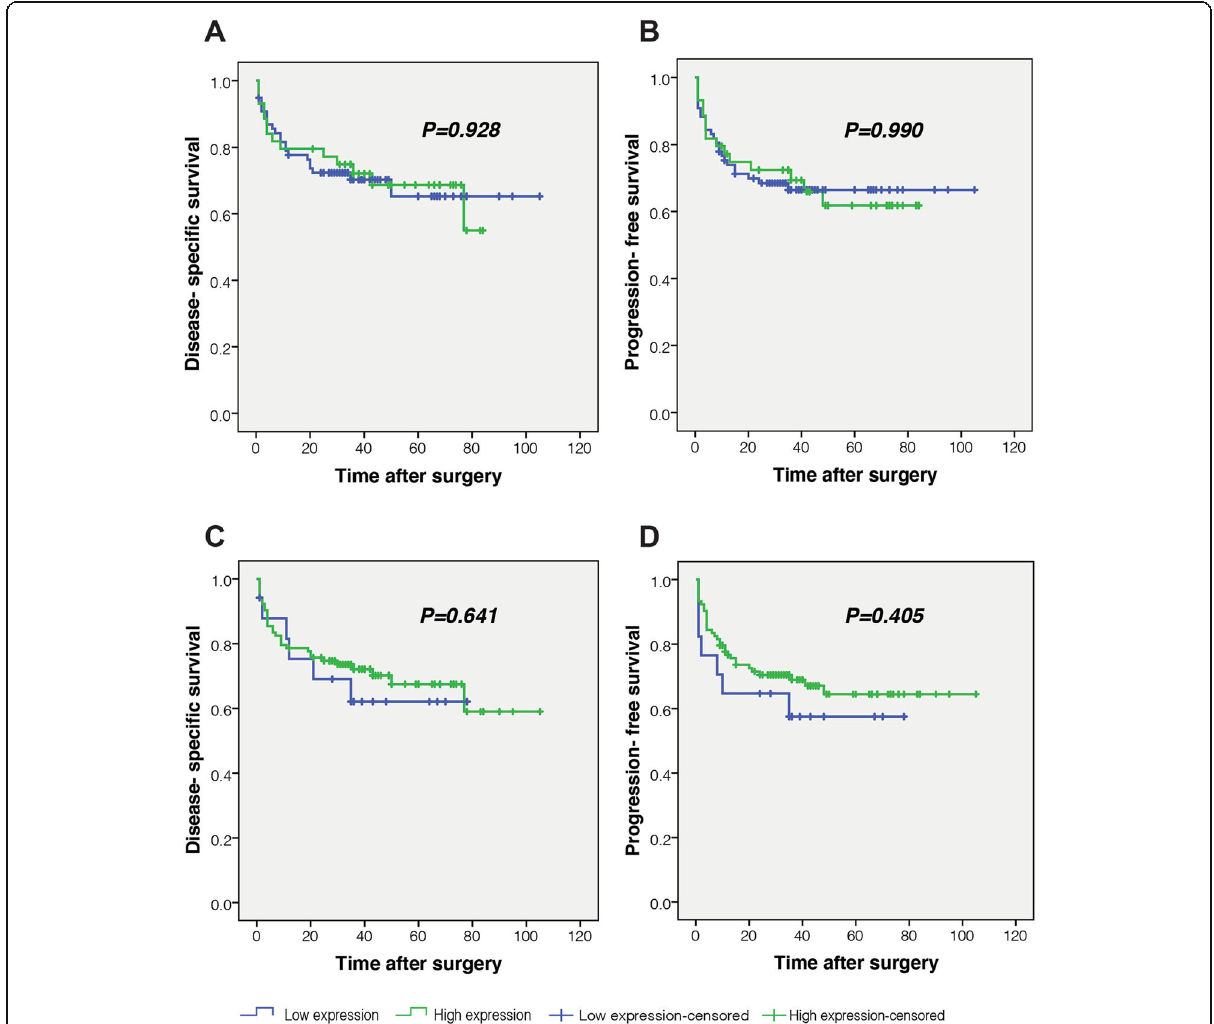
Fig. 5 Kaplan-Meier curves for disease-specific survival (DSS) and (PFS) according to the expression levels of CD105 in colorectal cancer. (Endothelial and cytoplasmic CD105 expression in tumor cells was divided into two groups: high and low expressions ’ levels). a, b Log Rank test showed no significant differences in survival (DSS and PFS) between patients with high and low cytoplasmic CD105 expressions in tumor cells (Survival analysis: DSS ( P = 0.928) and PFS ( P = 0.990)). c, d There were no significant differences in terms of survival (DSS and PFS) between patients with high and low CD105 expressions in endothelial cells using Log Rank test (Survival analysis: DSS ( P = 0.641) and PFS ( P =